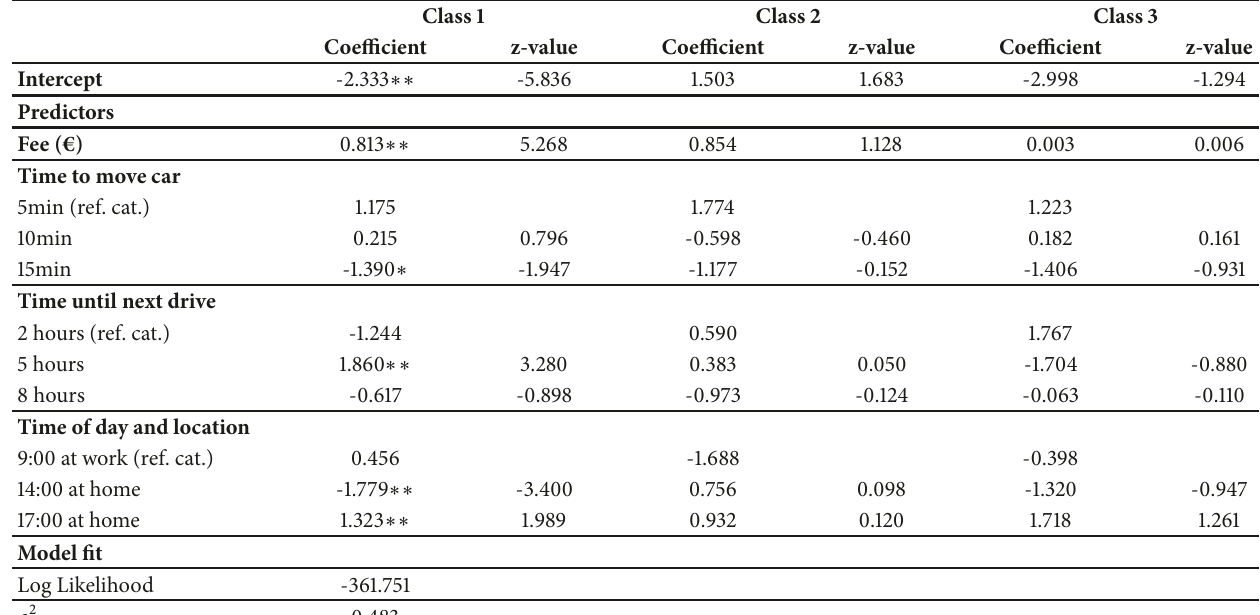
Table 6: Results of latent class model estimation.